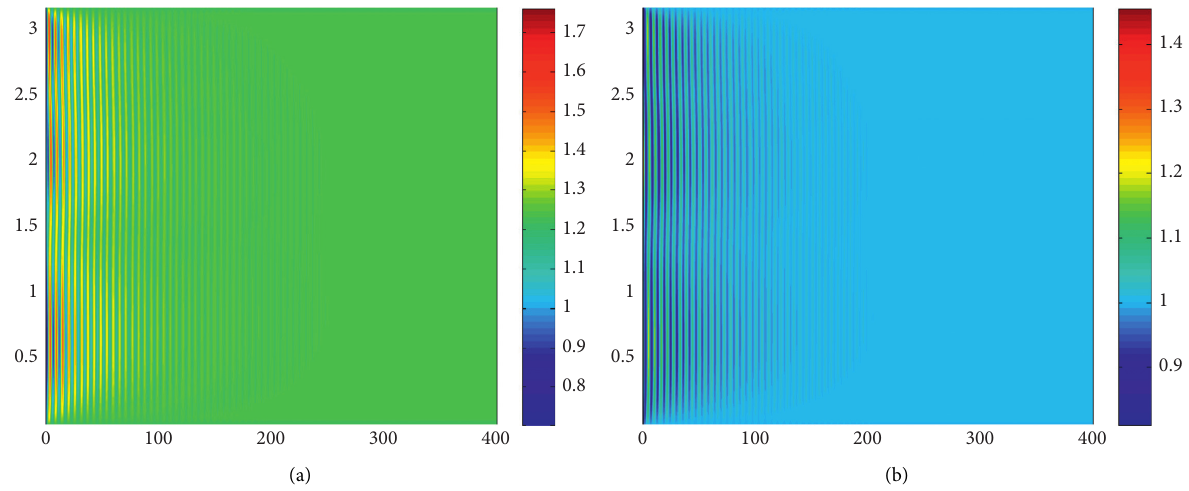
Figure 6: The spatial pattern of the system with Dirichlet boundary for τ ( t,x ) . (b) Spatial pattern of y y 1